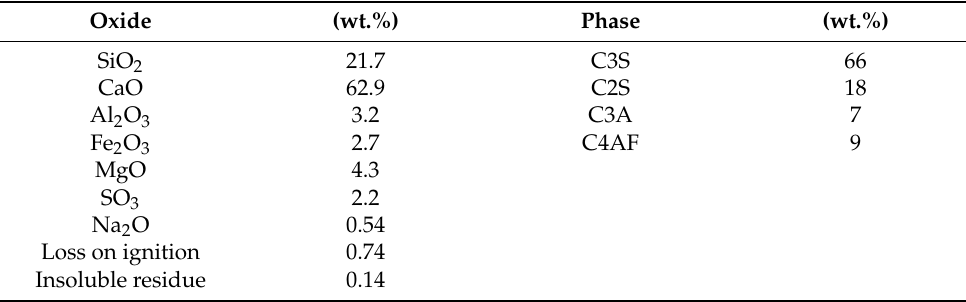
Table 3. Composition and properties of Class G